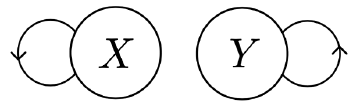
Figure 3 . Excitations of 1 / 4 -BPS giant gravitons det X and det Y . It turns out that the bifunda- mental arrows disappear and the nodes